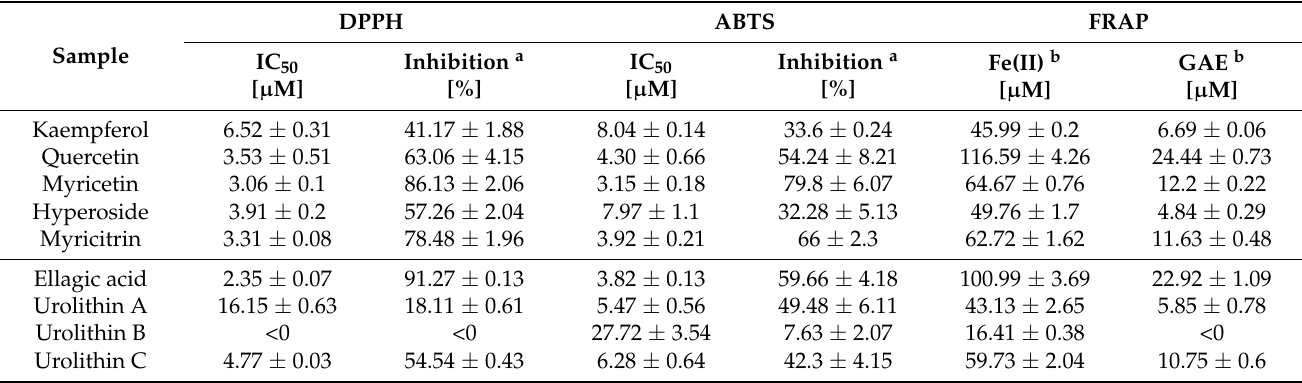
Table 4. Antioxidant effect of selected flavonols (aglycones, glycosides), and depsides (ellagitannin